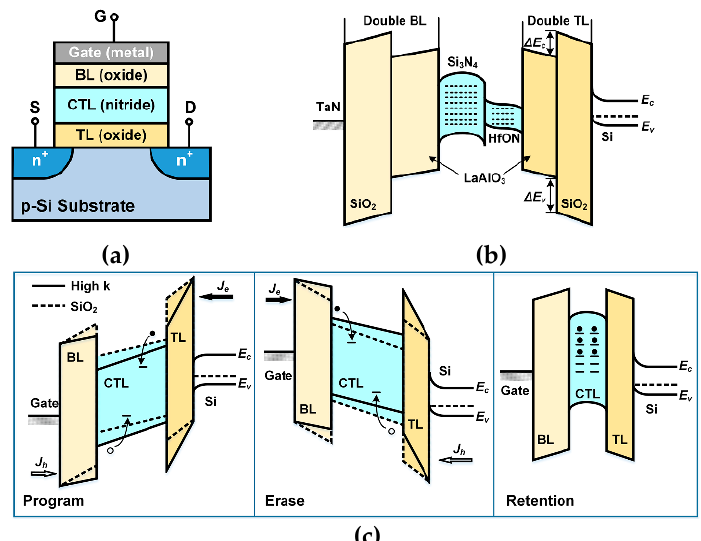
Figure 13. ( a ) Cross-sectional schematic of a MONOS CTM transistor; ( b ) energy band diagrams of CTM in program, erase and retention states; and ( c ) energy band of CTM with SiO 2 /LaAlO 3 double TL [78].